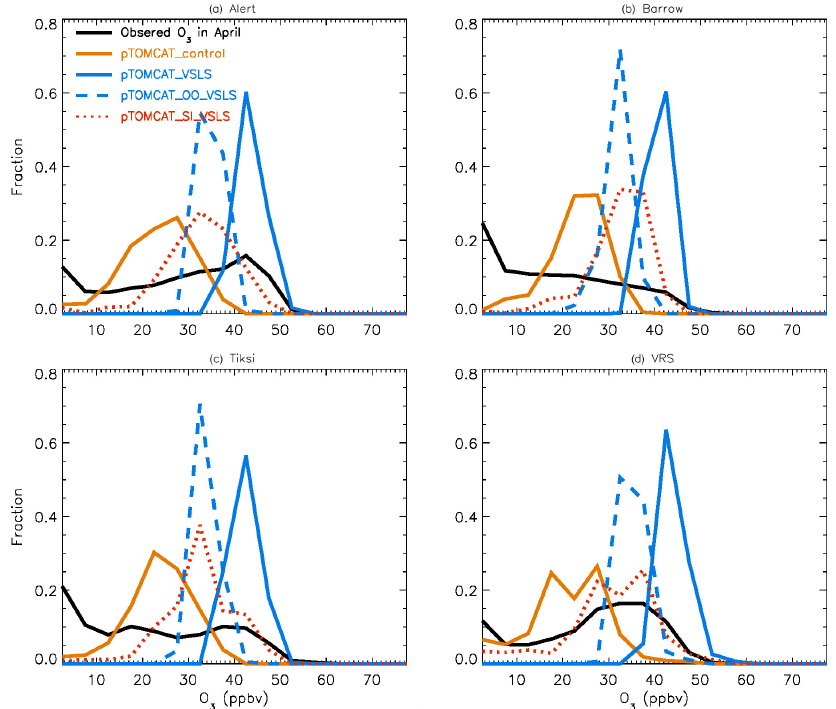
Figure 5. Same as Fig. 4 but for April. Also shown are the pTOMCAT_OO_VSLS results using a dashed blue line and the pTOM- CAT_SI_VSLS results shown by a dashed orange